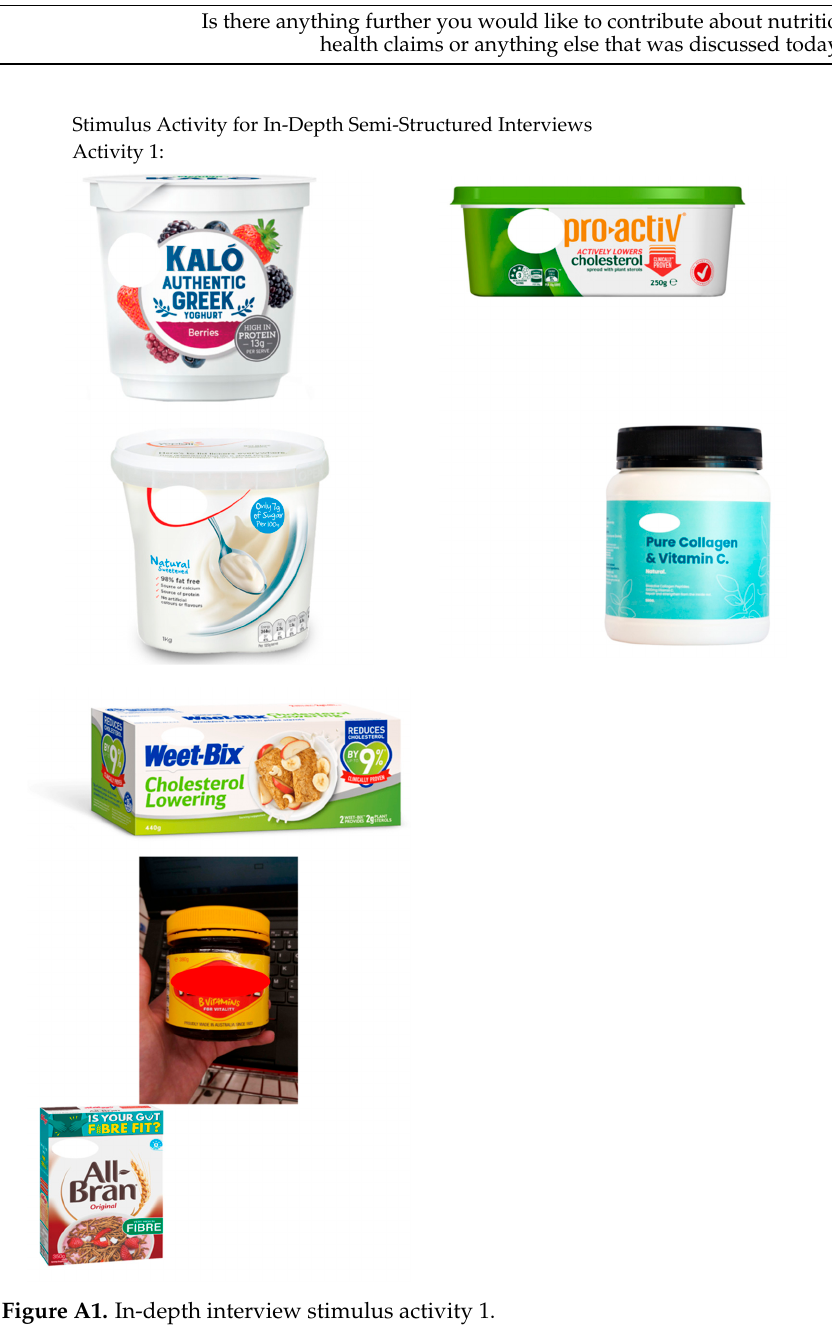
Figure A1. In-depth interview stimulus activity 1.